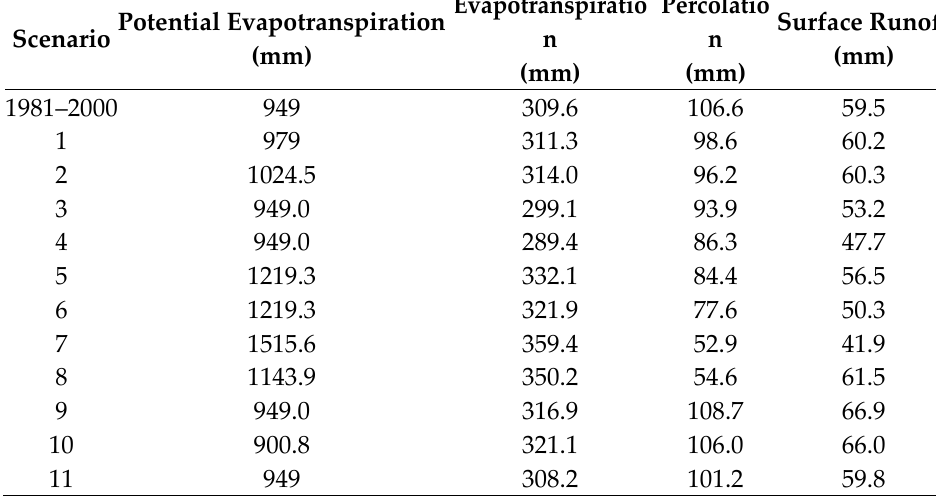
Table 2. The SWAT simulated hydrological budget components under the different hypothetical climate scenarios